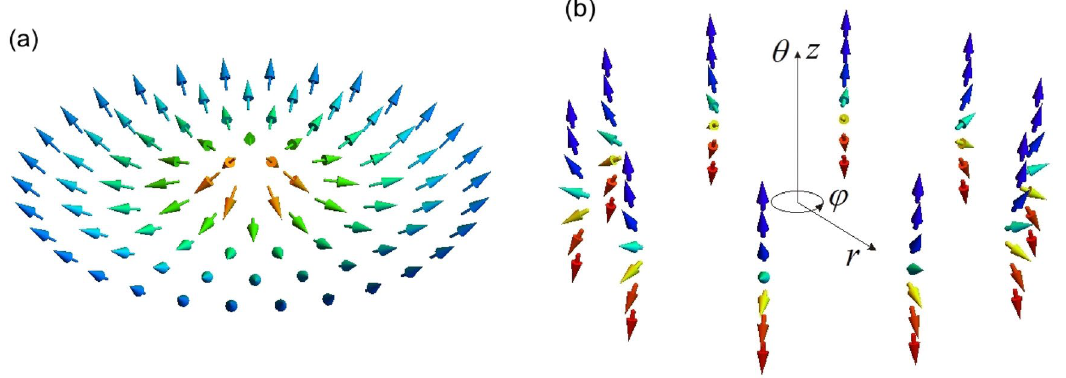
0.7 nm , 0 for the magnetic length ℓ 0 = = 5 nm . ( a ) Ring spin texture. ( b ) Magnetization ≈ 0 at z 2.5 nm to θ 2.5 nm for a π from θ π at z − = = ≃ − ≃